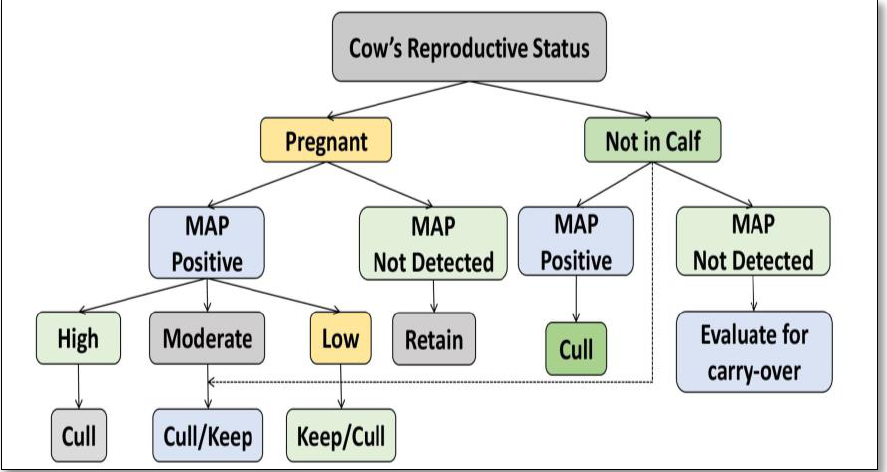
Figure 1. Control of Mycobacterium avium subspecies paratuberculosis (MAP) infection in domestic livestock .